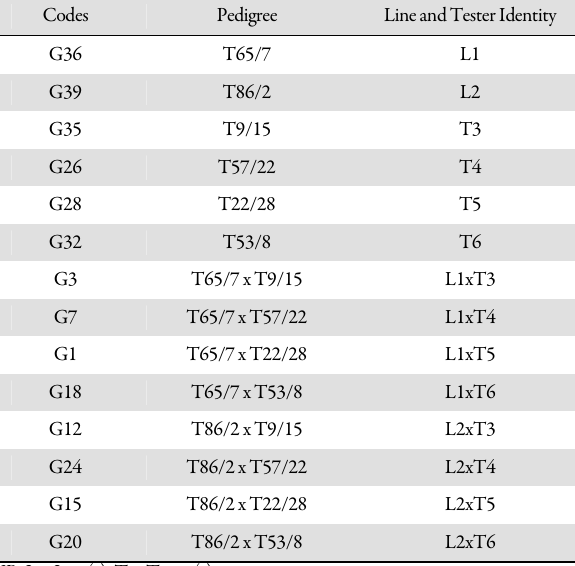
Tab. 1. Genetic identity of the cocoa genotypes Codes